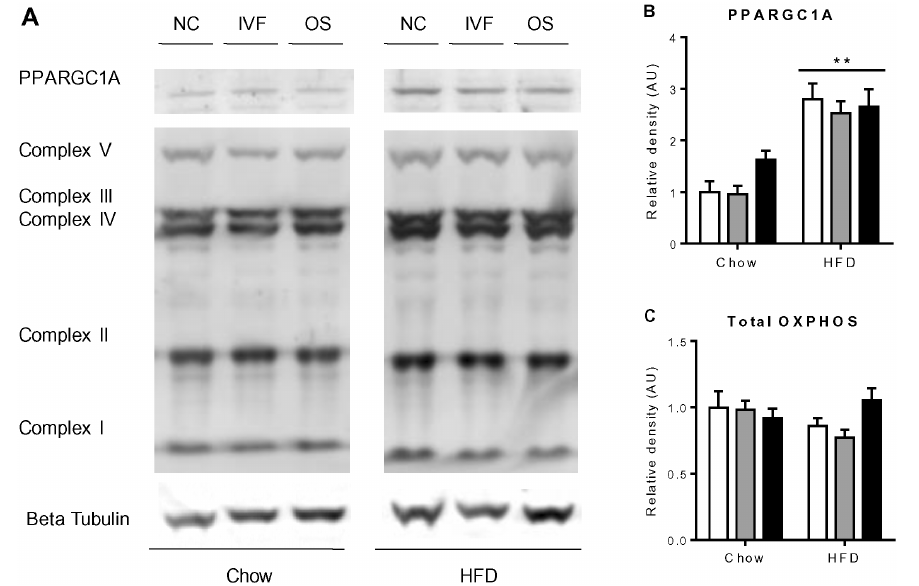
Figure 4. Protein levels of mitochondrial biogenesis markers PPARGC1A and total oxidative phosphorylation (OXPHOS) in liver of female mice offspring. White bars represent NC group, grey bars represent OS group and black bars represent IVF group (n=4). (A), representative blots of PPARGC1A, OXPHOS complexes I–V and beta-tubulin. (B), **Diet effect, P , 0.001.